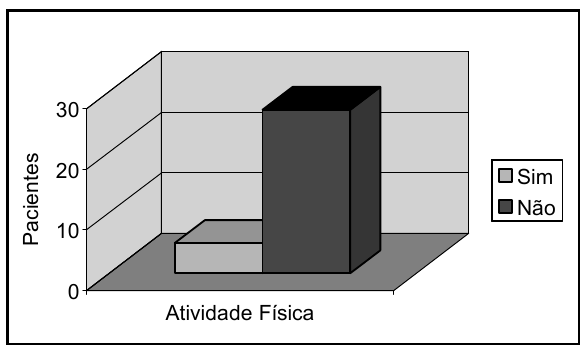
Figura 3 – Distribuição dos pacientes em relação à atividade física